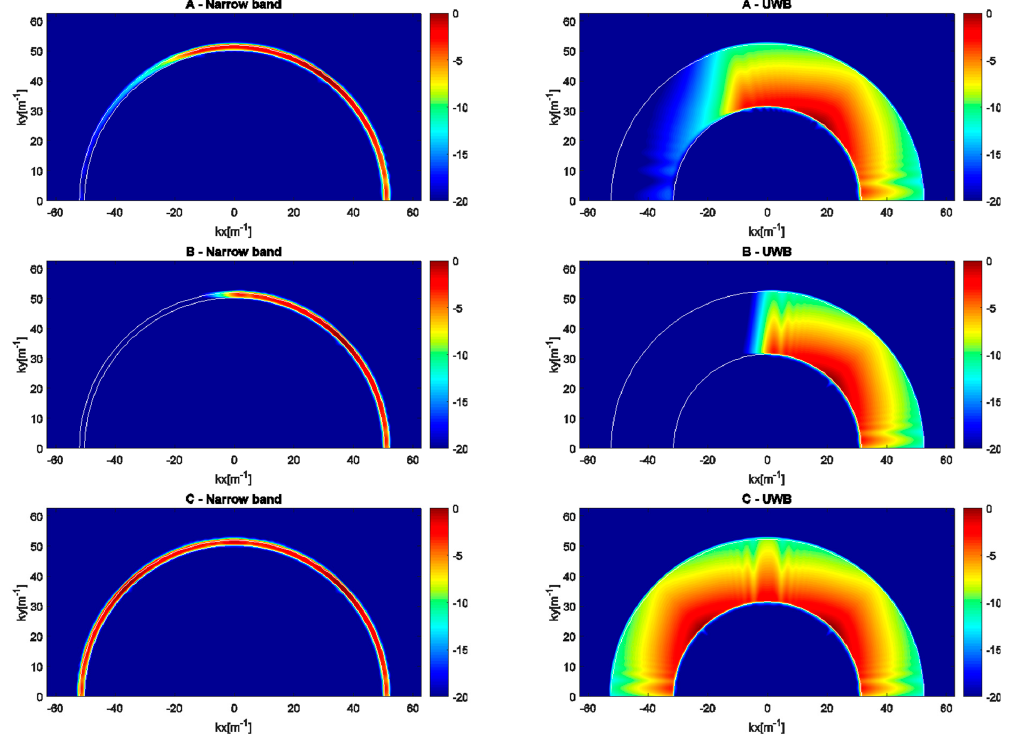
Figure 5. Normalized spectral content (in decibels) achievable with the sensing strategies A, B, C in the narrow band ( left panels ) and UWB ( right panels ) cases.